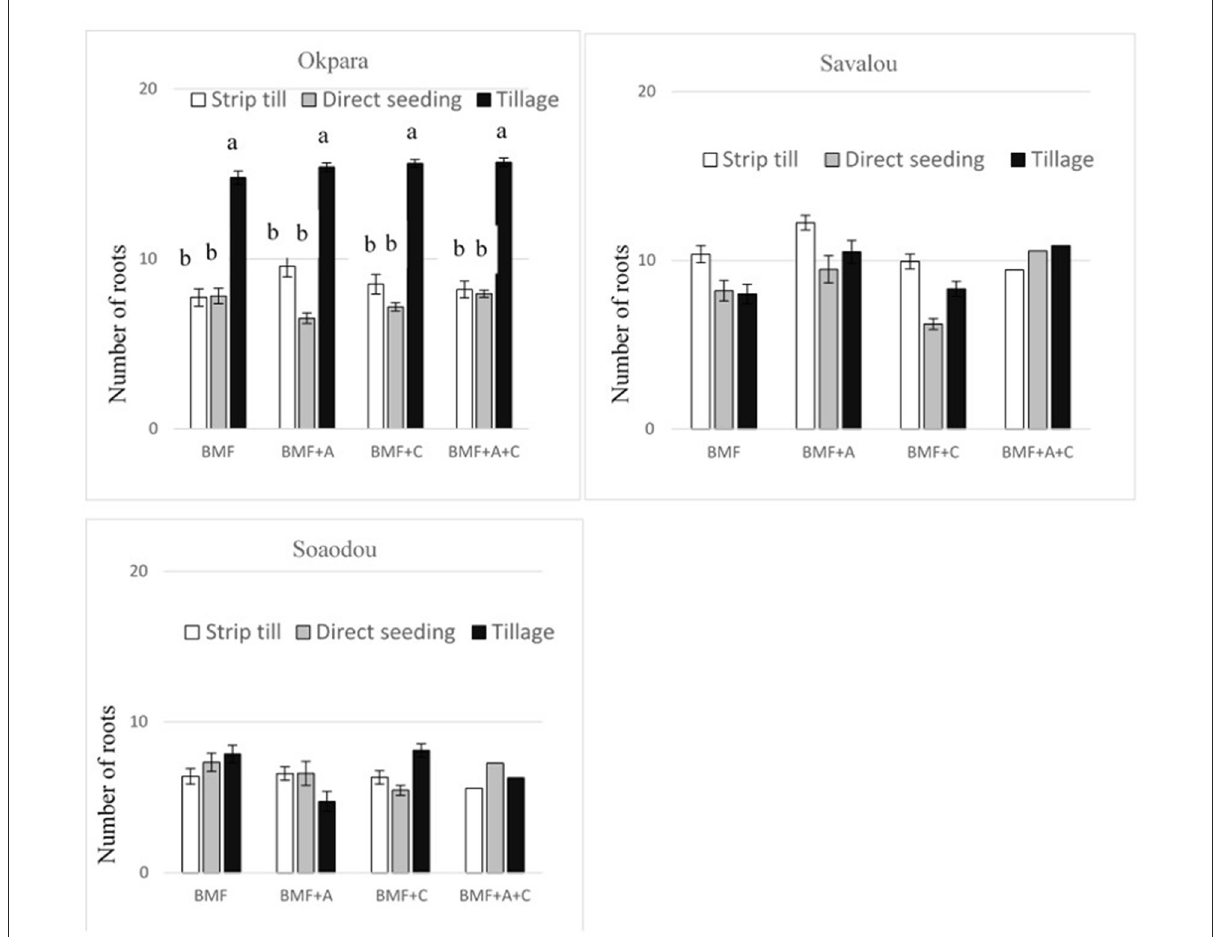
FIGURE4 Number of roots at 40 days after